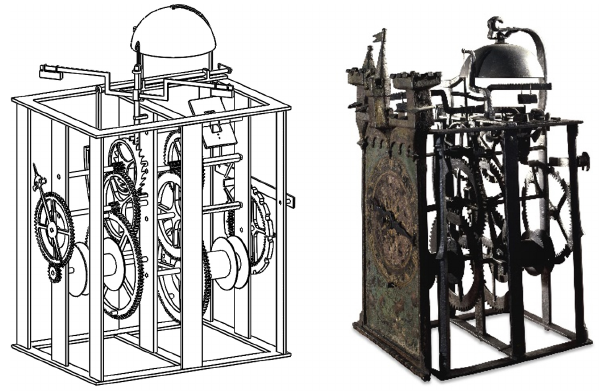
Figure 7. N1: German iron chamber clock (British Museum,